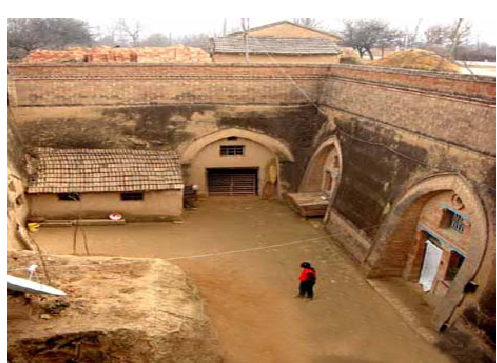
Figure 13. Cave-dwelling [13].